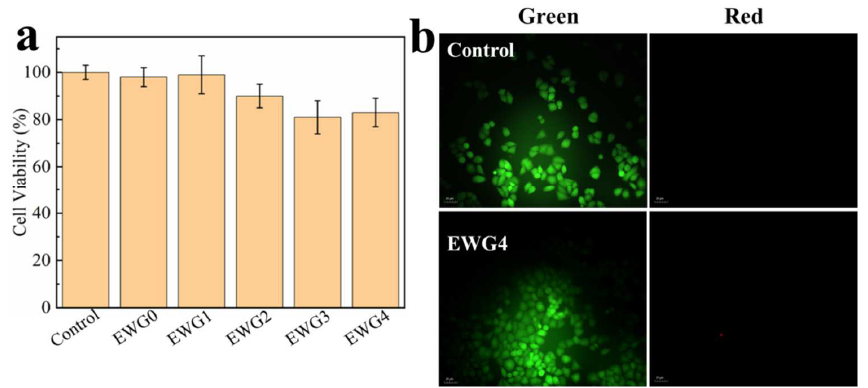
Figure 6. ( a ) Cell viability of HEK-293 cells on EWG0, EWG1, EWG2, EWG3 and EWG4 after 24 h culturing. ( b ) Live/dead staining florescent photographs of HEK-293 cells loaded with EWG4 for 48 h.